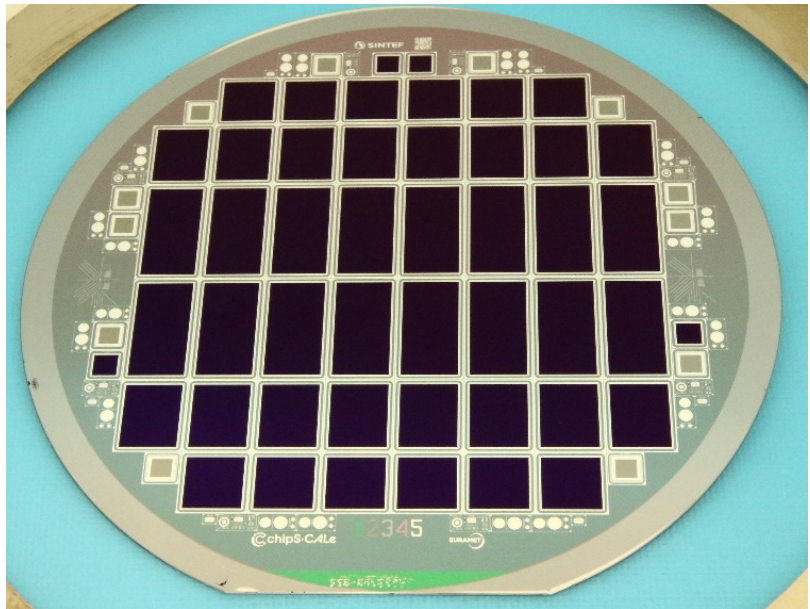
Figure 14. Completed 6-inch wafer of p-type inversion layer photodiodes passivated with SiO 2 /SiN x . The I–V characteristics of all photodiodes were measured at room temperature at wafer level. The measurements were carried out by using the biasing scheme shown in Figure 1. The measurement results show some variation across the wafer and between wafers, with typical active area leakage current values in the range of 1–5 nA/cm 2 at reverse bias voltage of − 20